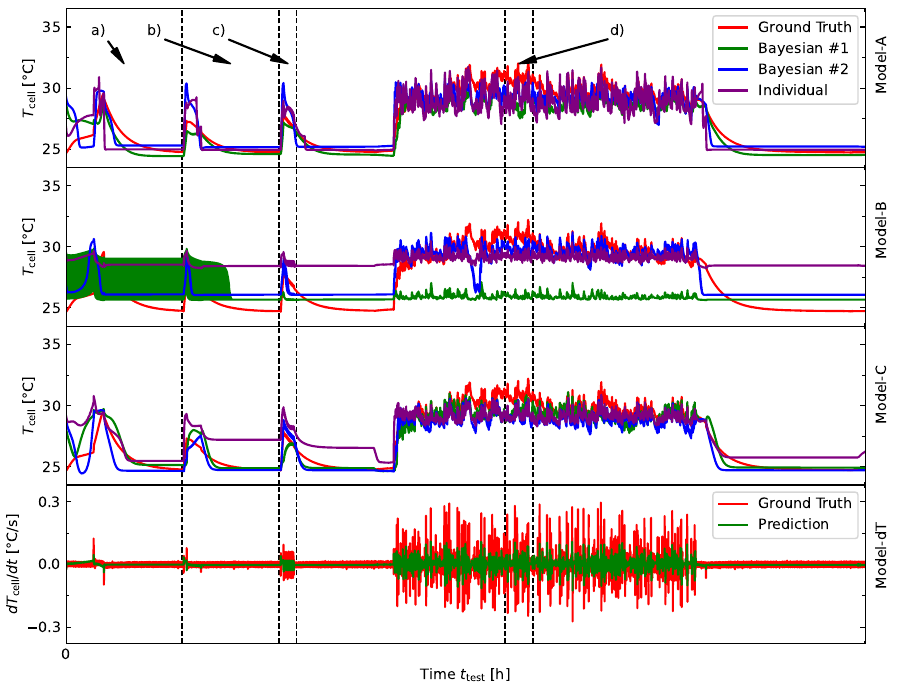
Figure 10. Predicted values of all models in four subfigures are given for the testing data set. Model-A to Model-C show ground truth, Bayesian #1, Bayesian #2 and the most promising individual results. Model-dT illustrates ground truth and the predicted values of the dT-Model. Four areas are marked from ( a – d